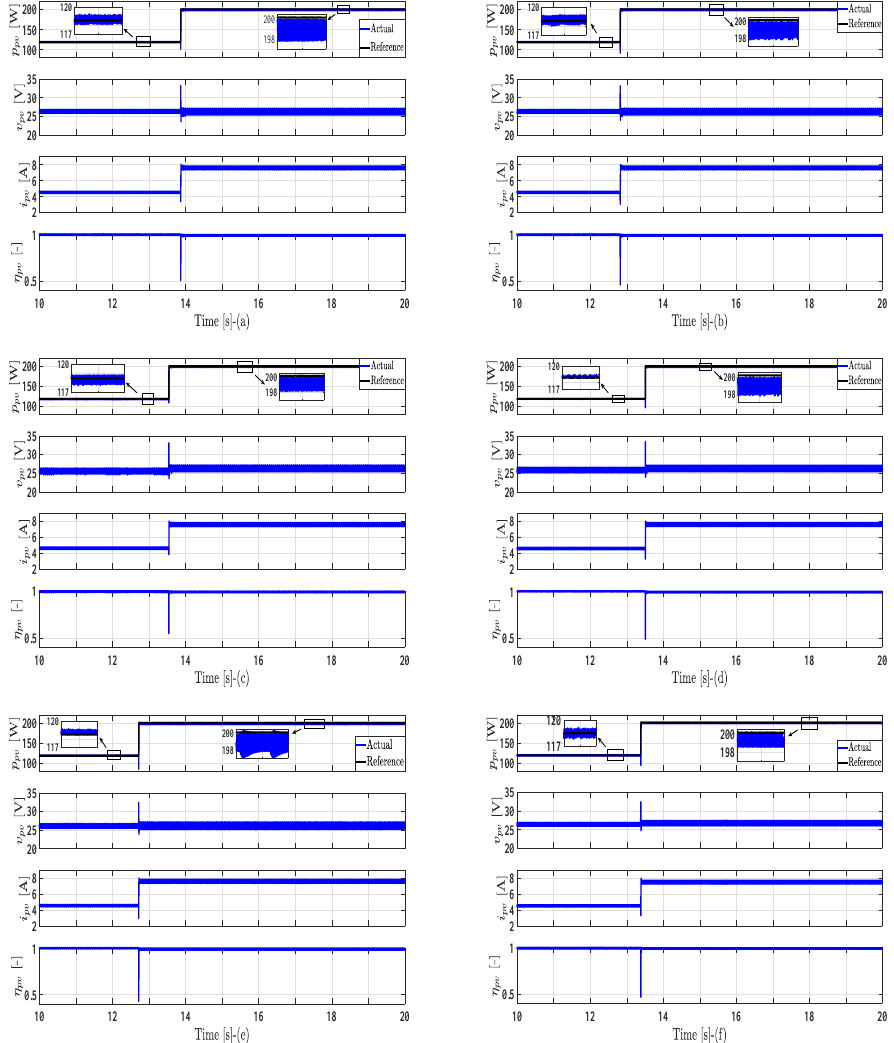
Figure 3. The performance of model-based MPPT methods at a step change of radiation. ( a ) Constant voltage method, ( b ) temperature method, ( c ) voltage-based method (V1), ( d ) voltage-based technique (V2), ( e ) current-based algorithm, ( f ) curve fitting